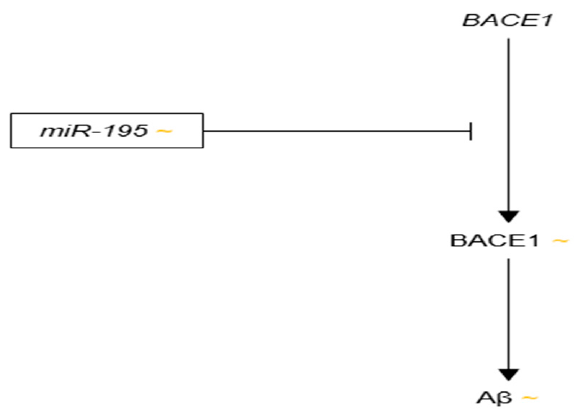
Figure 9. Regulation by miR-195. miR-195 inhibits the translation of BACE1. The yellow tildes (~) indicate the lack of consensus on the expression levels of miR-195 in AD brain, as well as the hypothetically unclear effects miR-195 on the levels of BACE1 and A β .